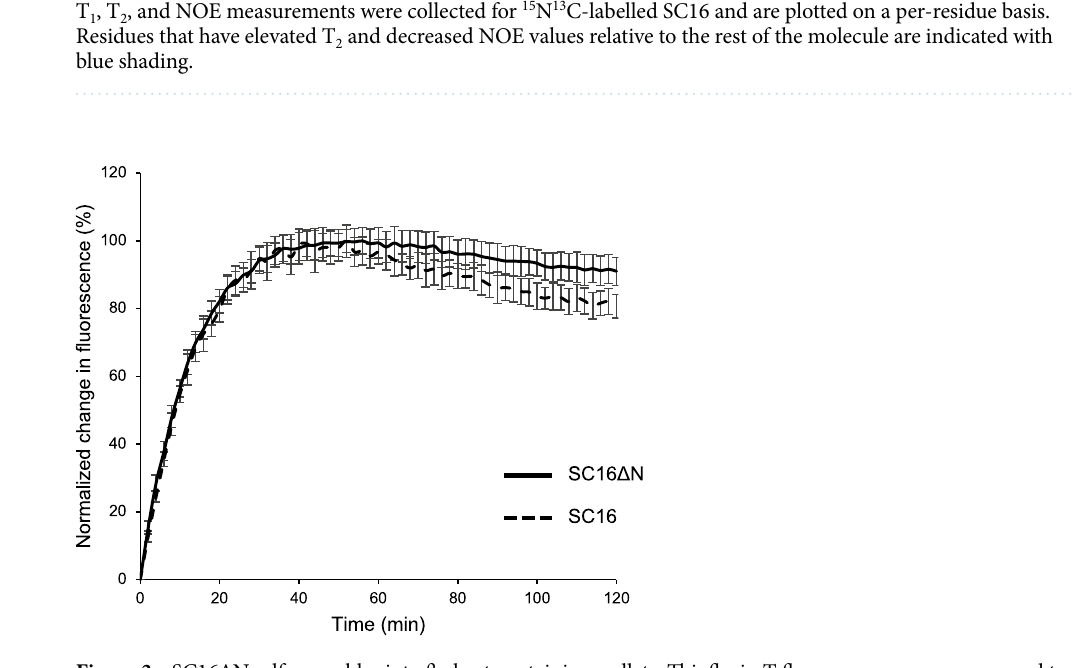
Figure 3. SC16ΔN self-assembles into β-sheet containing rodlets. Thioflavin T fluorescence assays were used to monitor the assembly of SC16 (dashed line) and SC16ΔN (solid line) during agitation. ThT assays were carried out at pH 8.5 with 1 M NaCl. Error bars represent standard deviation from 6